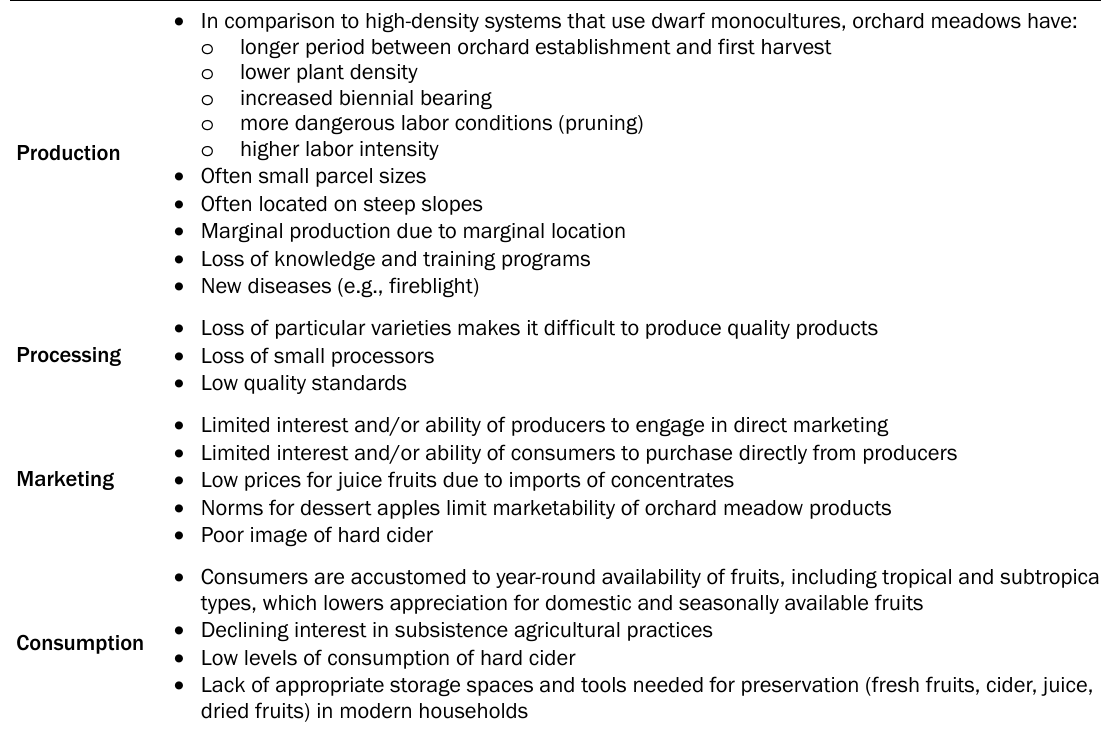
Table 4. The Decline of Orchard Meadows, Classified Using an Agroecological Perspective (Francis et al.,